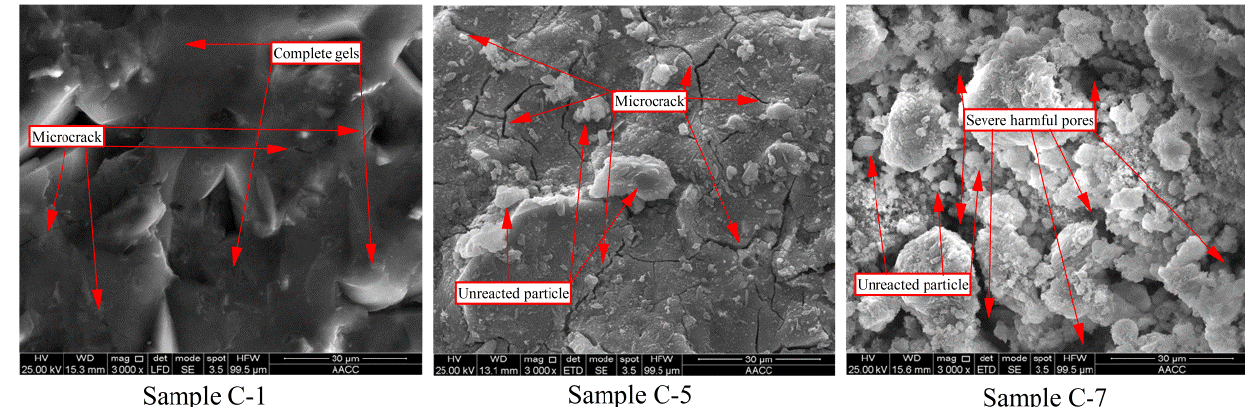
Figure 5. SEM analysis of samples C-1, C-5, and C-7 (magnification ×3000).